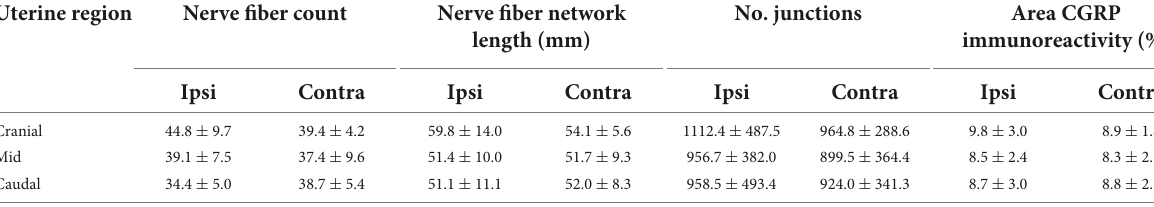
TABLE 1 Measurements of CGRP-expressing uterine nerve fiber characteristics following lumbosacral DRG removal. Uterine region Nerve fiber count Nerve fiber network No. junctions